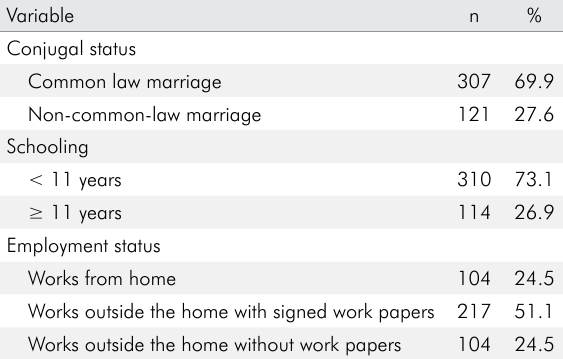
Table 1. Demographic and socioeconomic characteristics of guardians of preschool children. São José dos Pinhais, PR, Brazil (n =